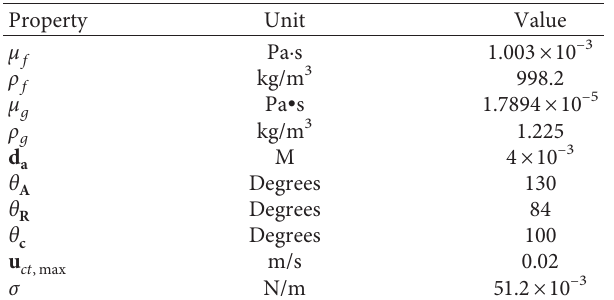
Figure 3: Measurement of advancing contact angle from experimental snapshot in [31]: (a) second picture of Q � 301.6cm 3 /min; (b) second picture of Q � 603.2cm 3 /min; (c) fourth picture of Q � 603.2cm 3 /min. Table 1: Input data for validation of dynamic contact angle